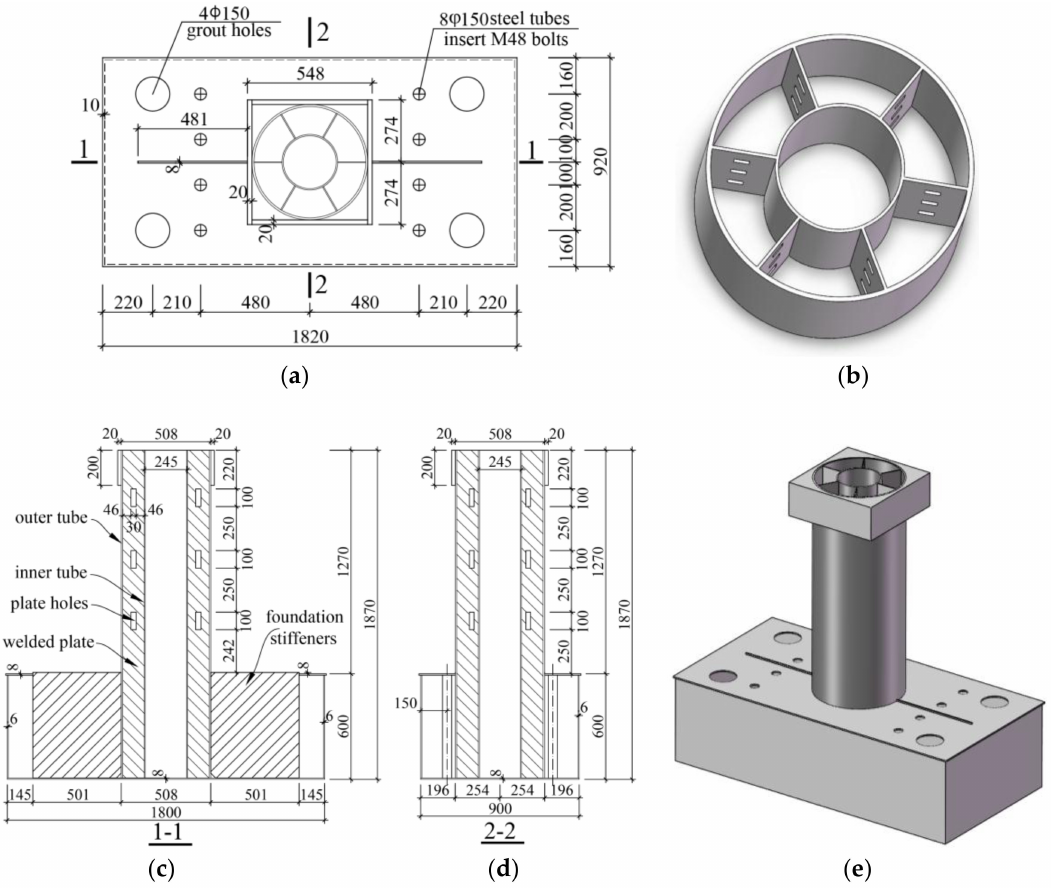
Figure 2. Dimensions and details of CFST-MC. ( a ) top view of specimen; ( b ) stereogram of cavity structure; ( c ) section 1-1; ( d ) section 2-2; and ( e ) stereogram of whole